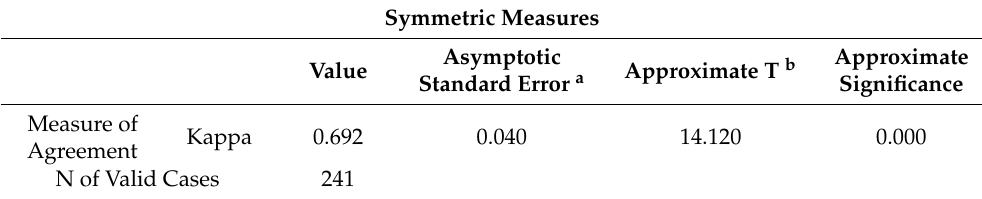
Table 2. Symmetric Measures—Kappa